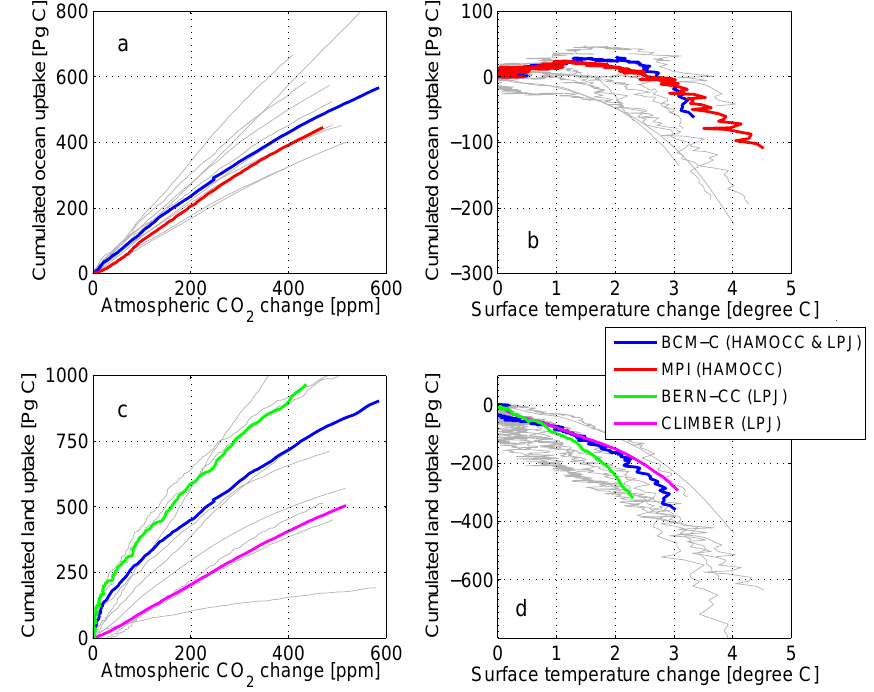
Fig. 5. The sensitivity of the (a, b) oceanic carbon uptake to change in atmospheric CO 2 concentration and surface temperature and (c, d) terrestrial carbon uptake to change in atmospheric CO 2 and surface temperature. Also plotted here are similar sensitivities of the other Earth system models (light-grey lines) and models with similar carbon cycle components: MPI (Max Planck Institute, red lines), BERN-CC (Bern Carbon-Cycle Climate model, green lines), and CLIMBER (CLIMBER2-LPJ, purple